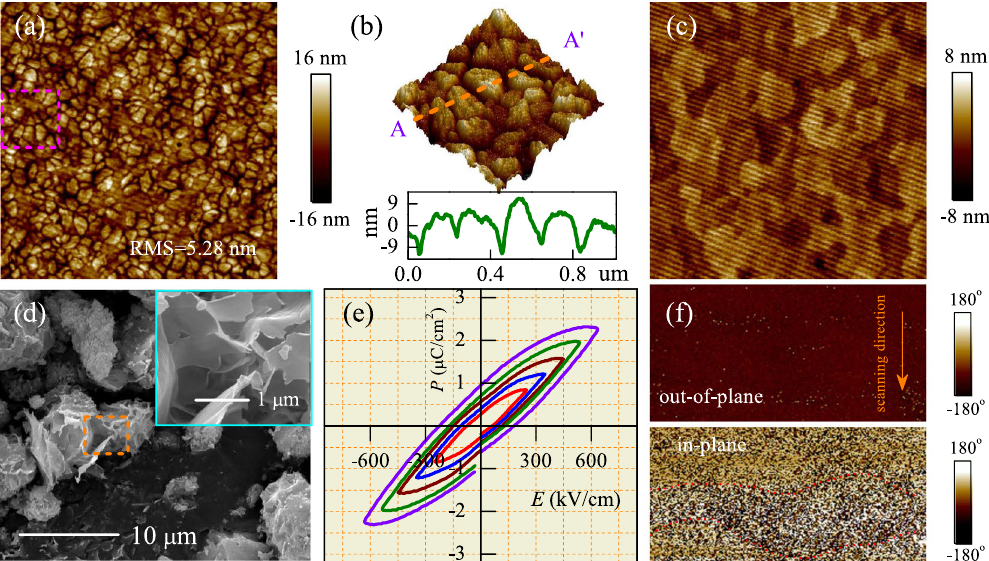
Figure 2. ( a ) 2D AFM images of KN-Pt, note that the measured area is 5 × 5 μ m 2 . ( b ) 3D AFM image of KN-Pt is the enlargement of the dashed box in ( a ), and the measured area is 1 × 1 μ m 2 . Note that the inset data shows the section analysis of the 3D AFM image based on the AA ′ area. ( c ) 2D AFM images of KN-quartz, note that the measured area is 1 × 1 μ m 2 . ( d ) SEM images of KN-NL. ( e ) Polarization-electric field ( P - E ) ferroelectric hysteresis loops of KN-Pt. ( f ) The phase of IPP and OPP signals for the KN-Pt film. Note that the short dash areas indicate the possible domain, and the measured area is 500 × 250 nm 2